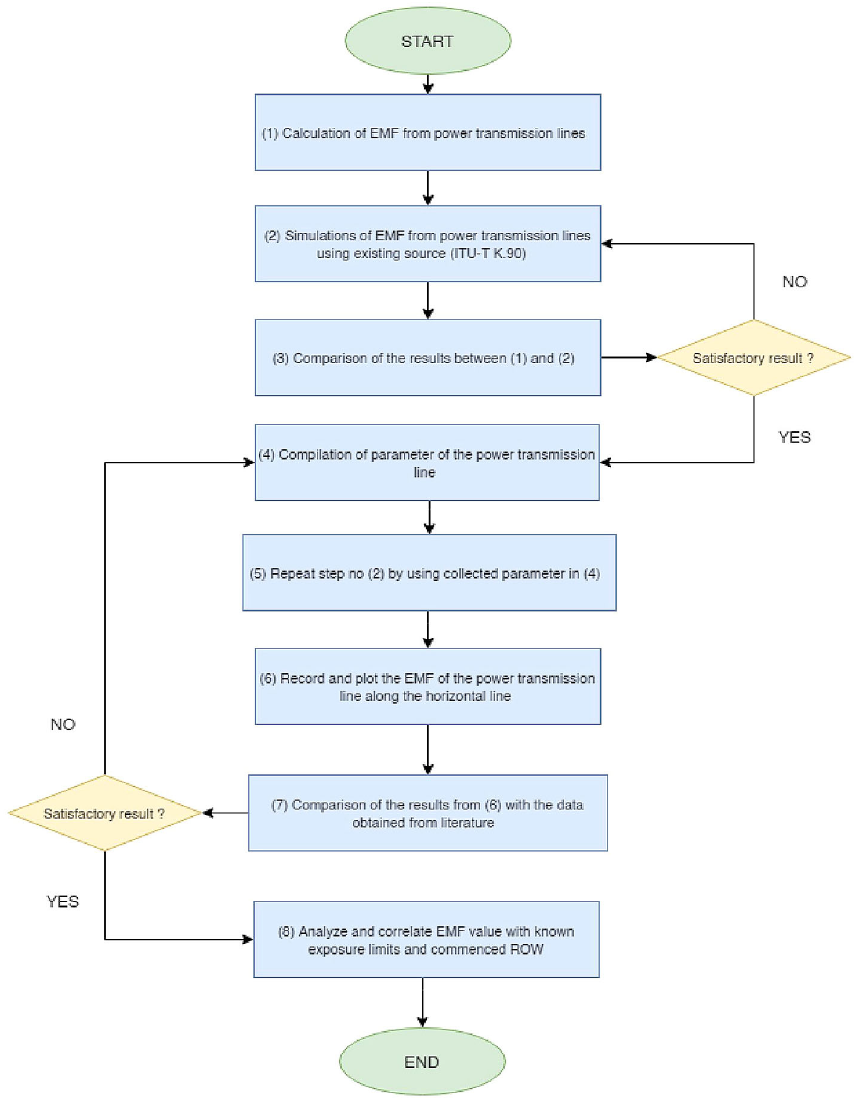
Figure 2. Overall project